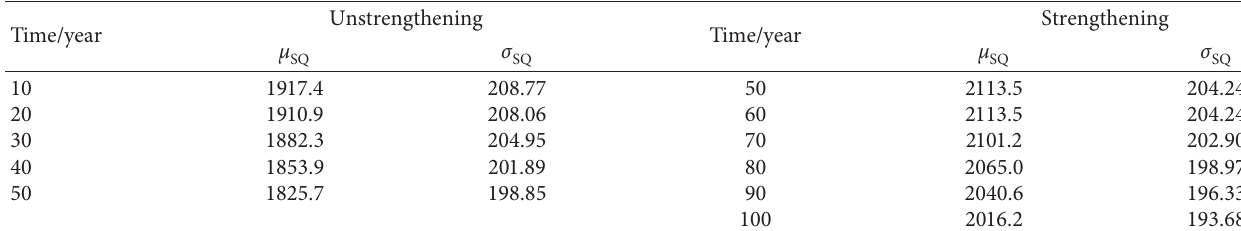
Figure 2: Cross section drawings (unit: cm). (a) Middle girder. (b) Side girder. (c) Girder cross section. Table 2: Mean and standard deviation of resistance (kN · m).